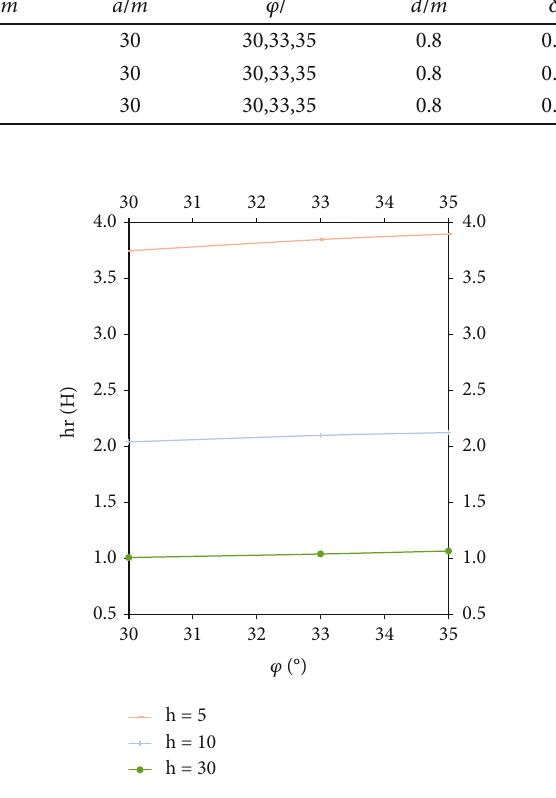
Figure 5: The relationship between unloading in fl uence depth ( h and friction angle ( φ Table 5: The ratio of h